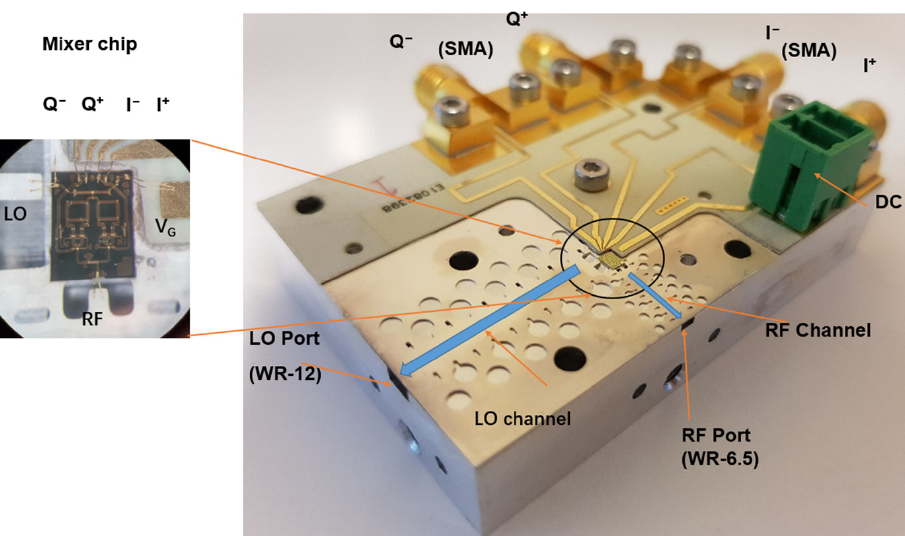
Figure 13. Fabricated D-band mixer assembly and detailed transition with the waveguide. To characterize the packaged mixer, measurements were performed using Keysight PNA-X N5247A and an E-band frequency extender for the LO port, while Keysight PNA-X and a D-band VDI frequency extender were used to measure the RF port separately. The LO/RF ports’ measured return loss for the mixer is shown in Figure 14; S11 is below − 10 dB for most of the operating LO and RF working frequency bands, which is acceptable for the D-band mixer module. The simulated transition performance (ideal matching load port) and measured transition performances (real mixer port) show apparent differences, which are mainly caused by the mismatch between the transition and the mixer chip (GMDR0035A mixer presenting the port’s return loss of 10 dB).